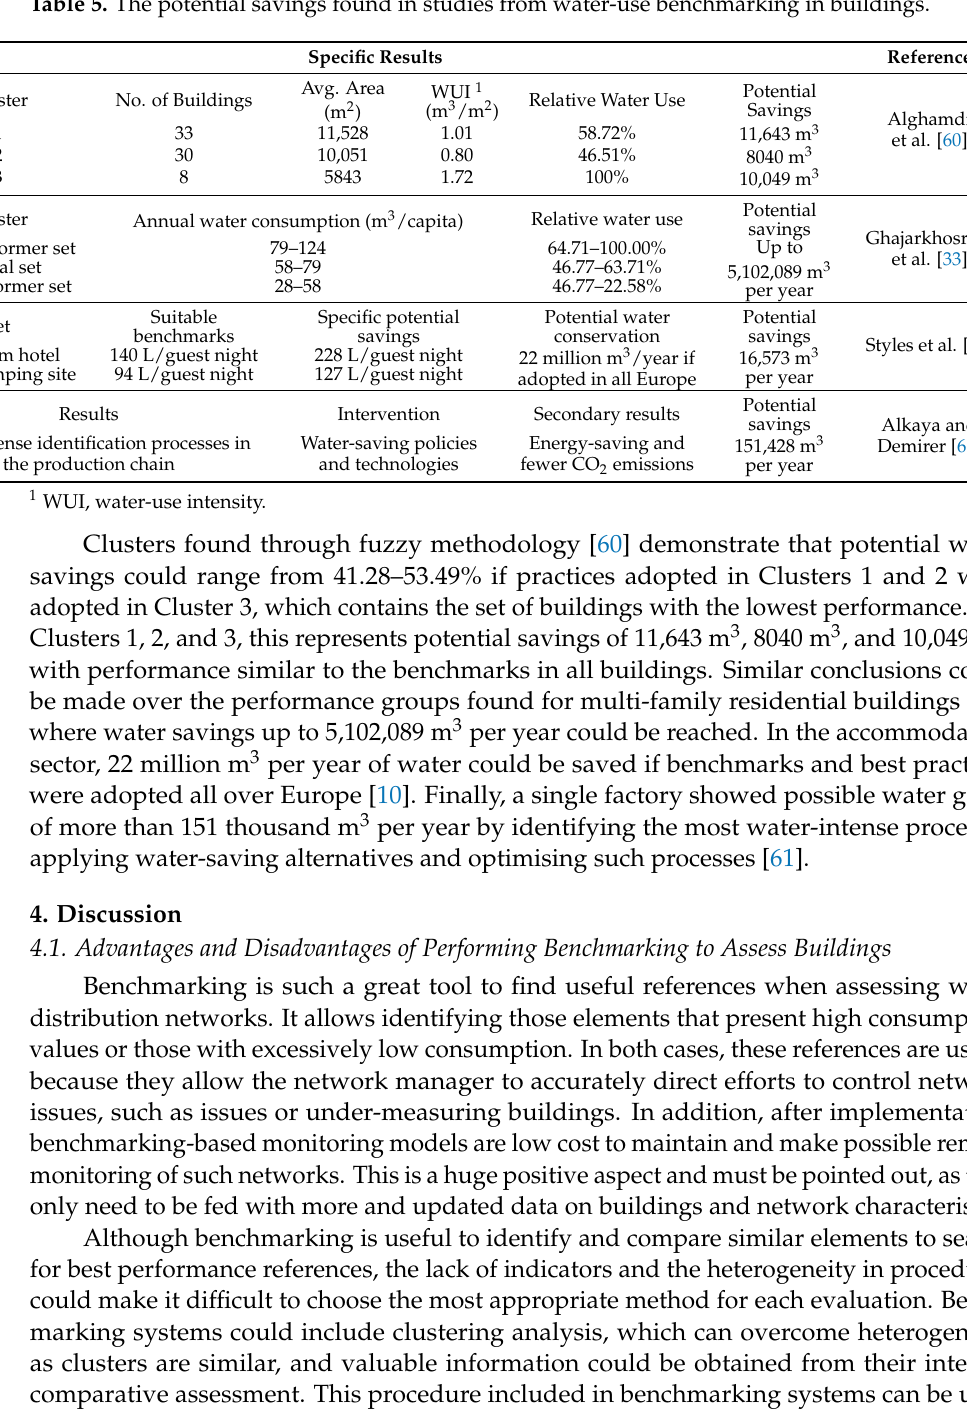
Table 5. The potential savings found in studies from water-use benchmarking in